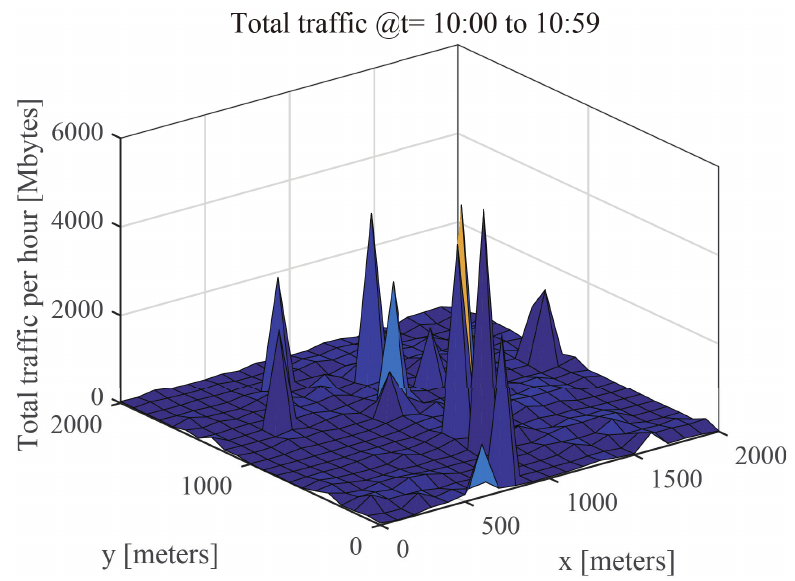
Figure 1. Sample of spatial distribution of measured traffic in ODC [27].